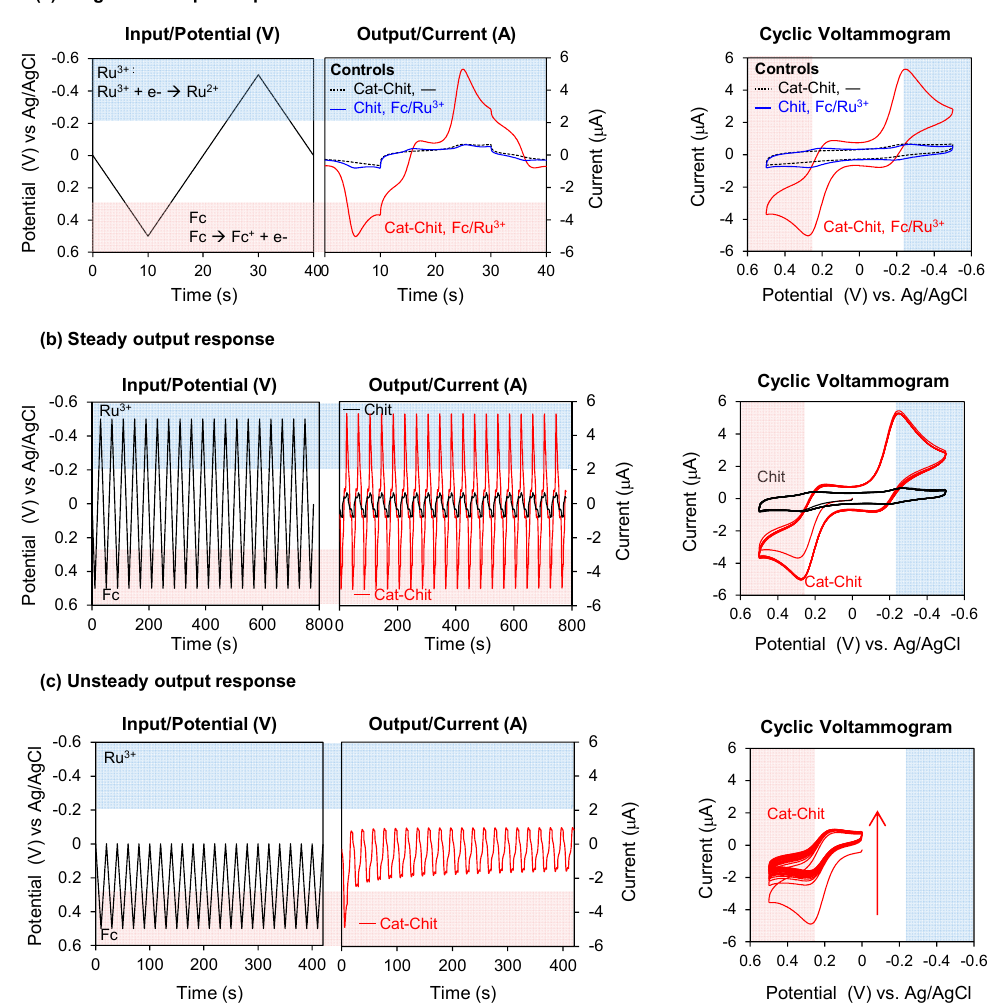
Figure 4. Molecular electronic properties of redox-capacitor. ( a ) Input–output curves and cyclic voltammogram show that the redox-cycling reaction of redox-capacitor with mediators results in output currents that are amplified, partially rectified and gated. ( b ) The output current of mediator is steady over time under unperturbed environment. ( c ) The output current becomes unsteady in the limited range of input potential. Cat-Chit: Catechol-modified chitosan film; Fc: Ferrocene dimethanol. Reproduced from [31] by permission of The Royal Society of Chemistry,